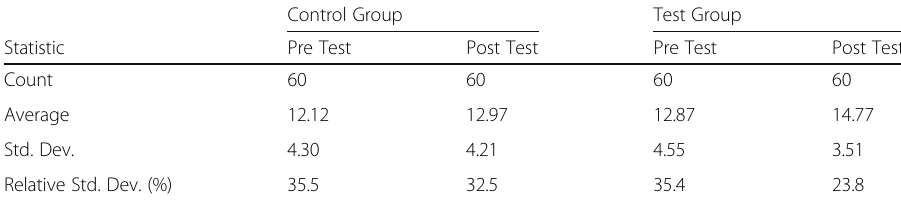
Table 1 Statistics for the Pre and Post Scores Control Group Test